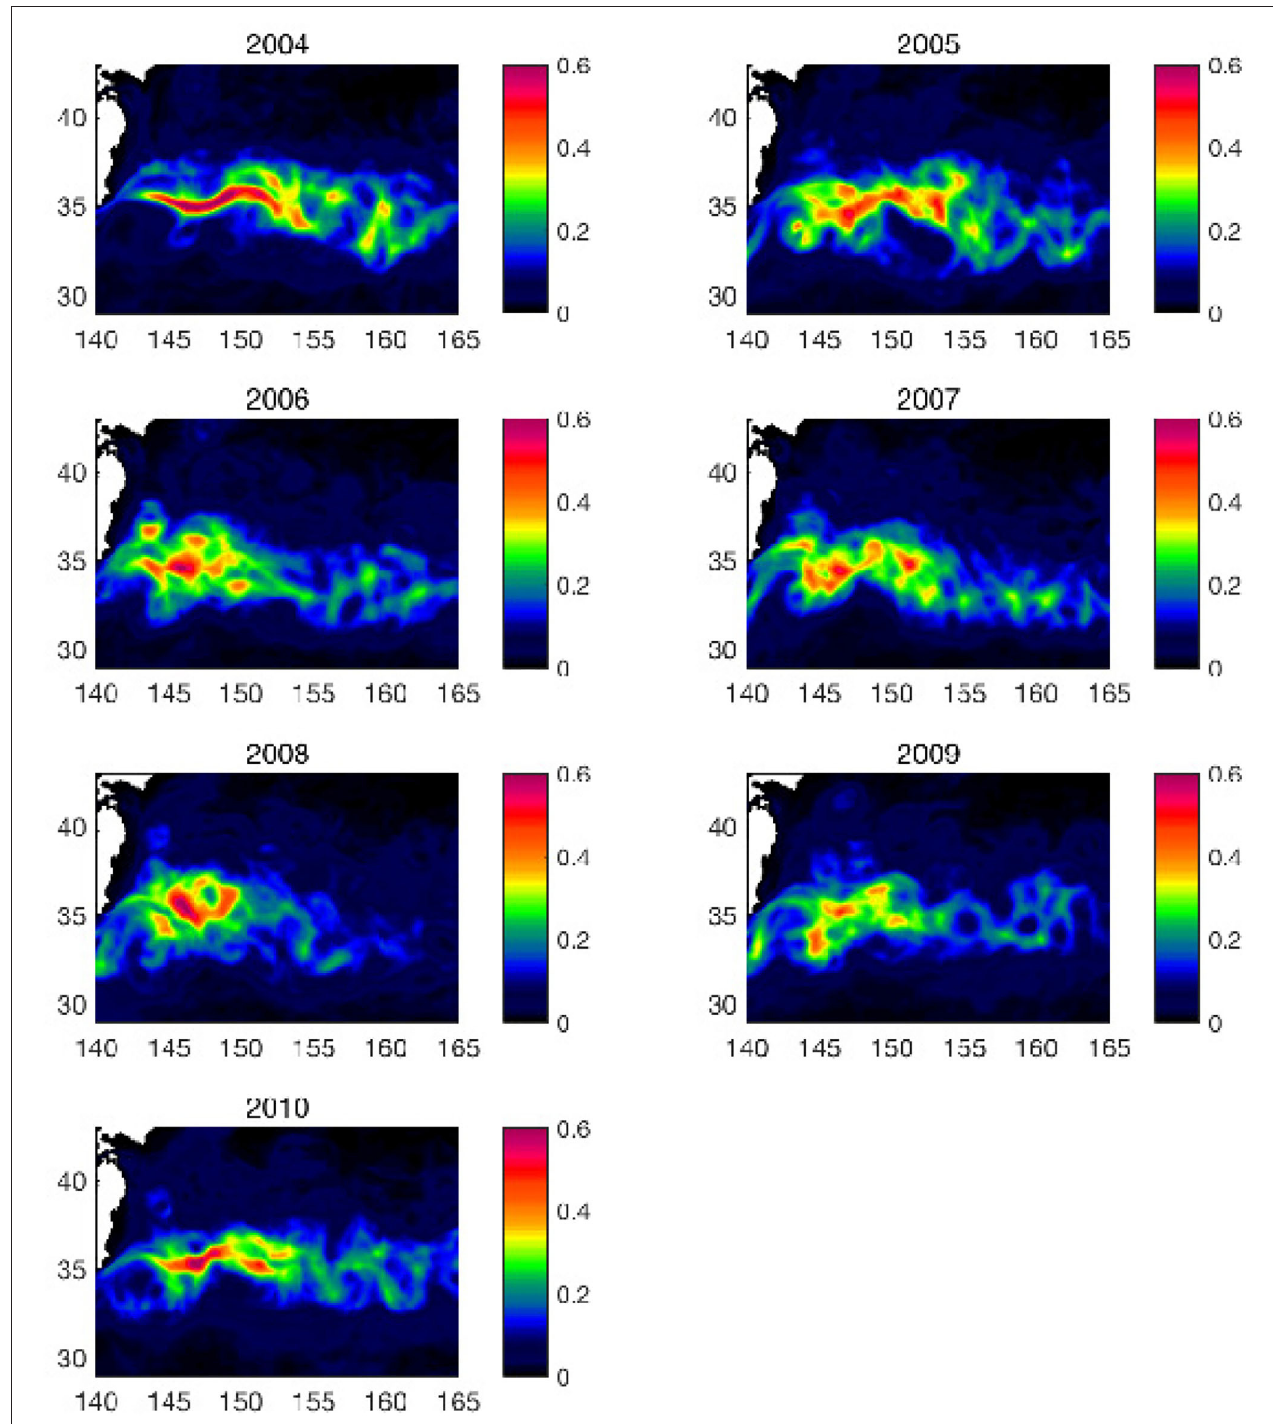
FIGURE 13 | Top 100-m annual mean eddy kinetic energy m 2 s − 2 from 2004 through 2010 obtained from FORA-WNP30 data using (6). The abscissa is longitude ( ◦ E) and the ordinate is latitude ( ◦ N).